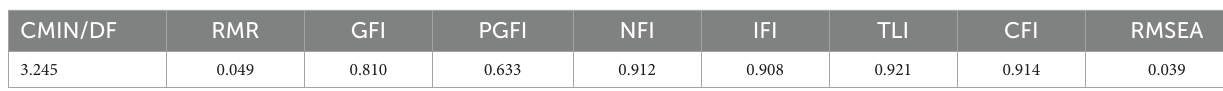
TABLE 4 Model fitting indicators.